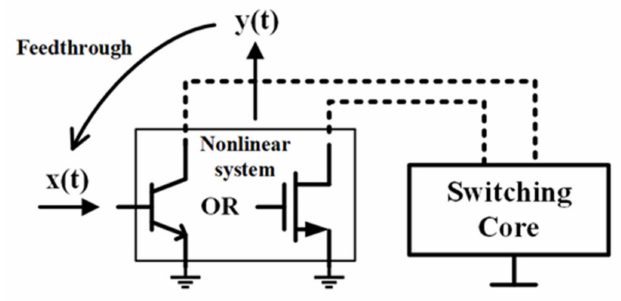
Figure 1. Block of nonlinear